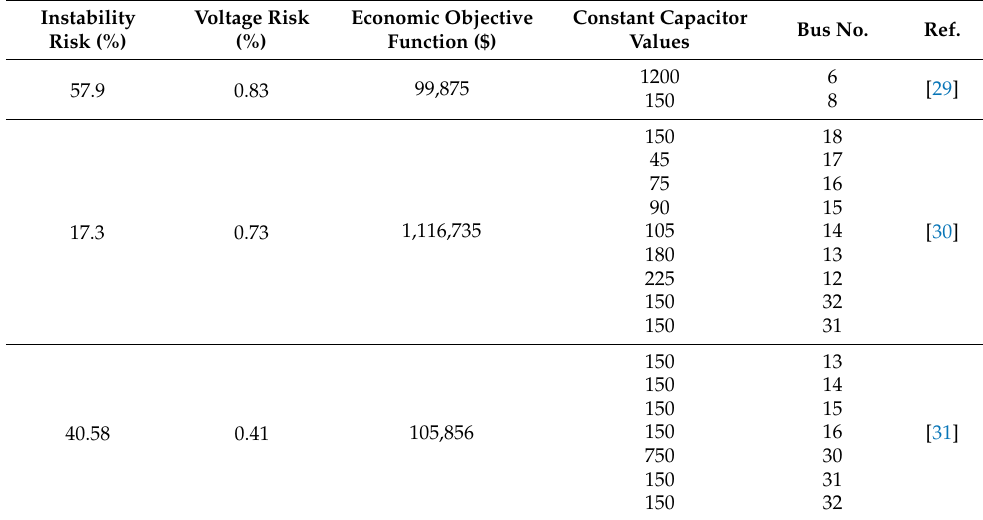
Table 6. Capacitor placement results in different references.